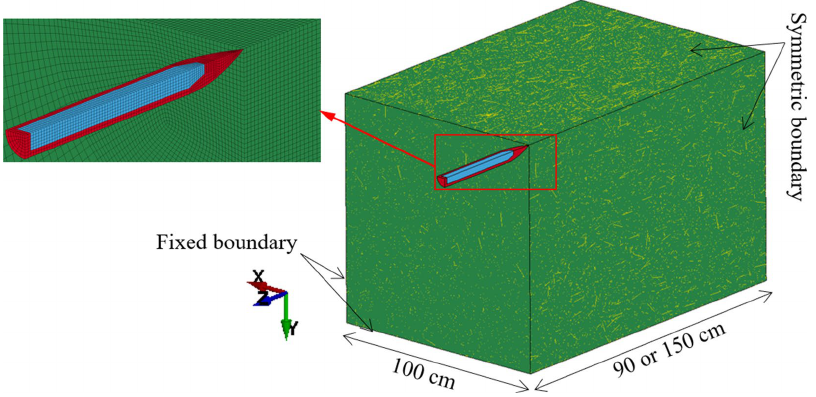
Figure 14. FE model for projectile penetration.